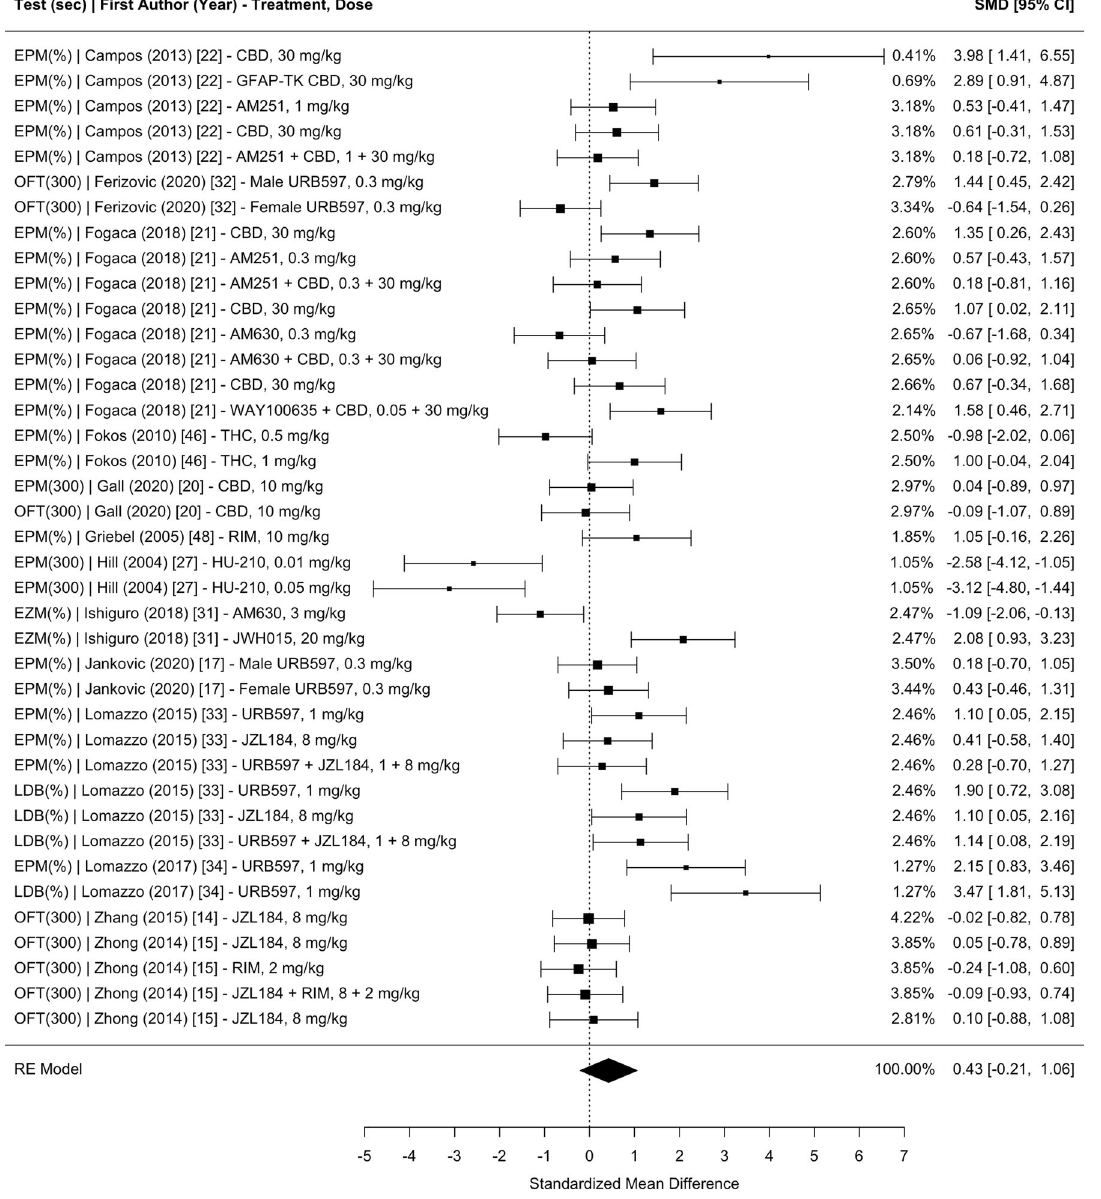
Fig. 5 Meta-analysis of studies investigating the effect of CB administration on exploration anxiety (i.e., % or time spent in the anxiogenic context) in CUS. Sec total time of the test in seconds, EPM elevated plus-maze, OFT open fi eld test, EZM elevated zero maze, LDB light dark box test, SMD standardized mean difference, CI con fi dence interval, CBD cannabidiol, GFAP-TK glial fi brillary acidic protein thymidine kinase transgenic mice, THC tetrahydrocannabinol, RIM